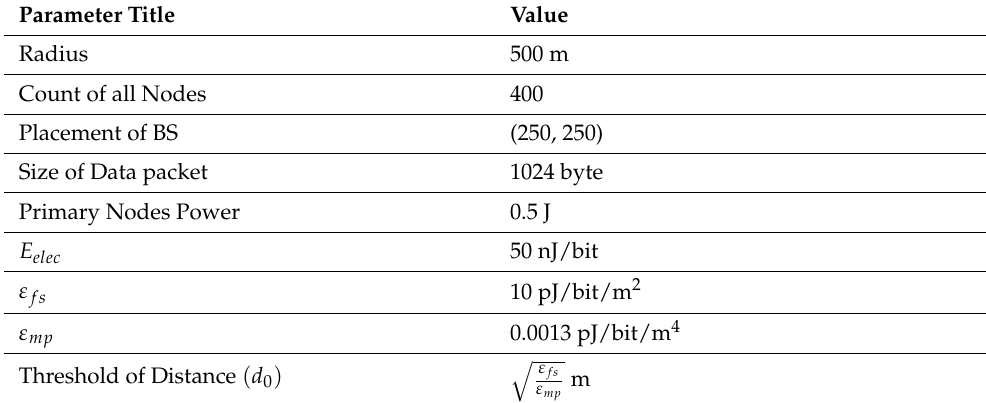
Table 2. Test parameters.